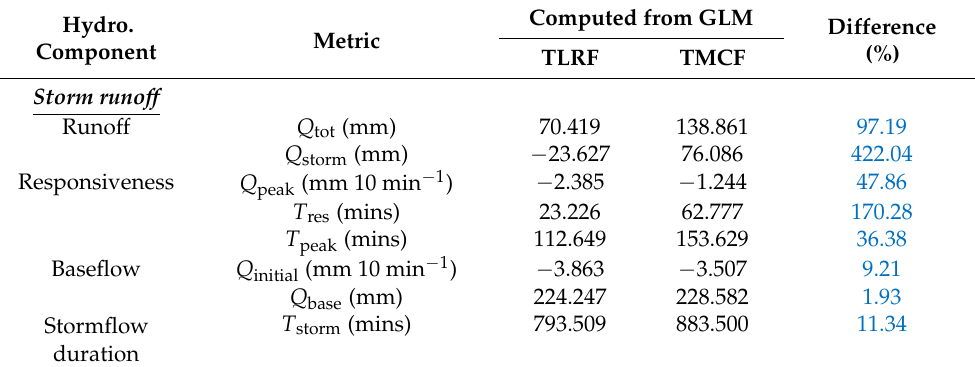
Table 5. GLM-computed hydrograph metrices in the TMCF and the TLRF. Hydro. component